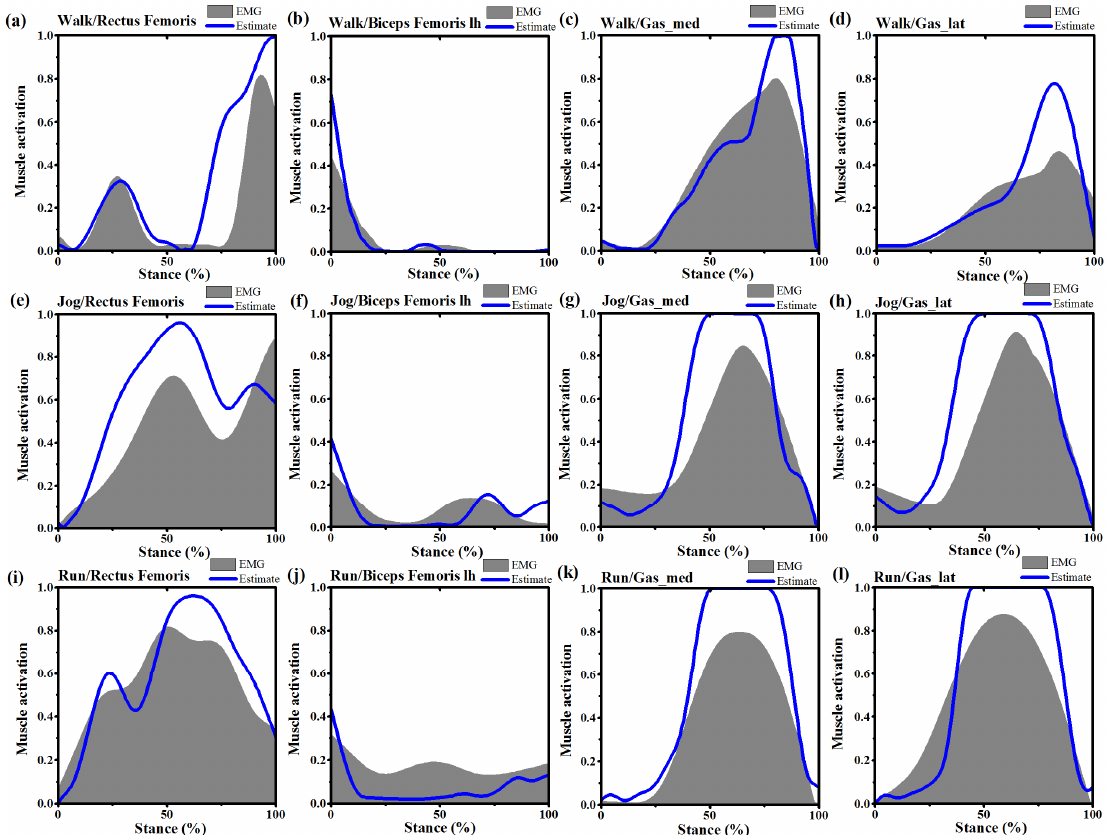
Figure 3. Comparison of muscle activations from static optimization estimated (blue line) and filtered electromyography (EMG) signals measured from one subject during the same trial of normal walking, jogging and running. ( a ): Rectus femoris muscle activation during stance phase of walking; ( b ): Biceps femoris lh (long head) muscle activation during stance phase of walking; ( c ): Gastrocnemius medialis (Gas_med) muscle activation during stance phase of walking; ( d ): Gastrocnemius lateralis (Gas_lat) muscle activation during stance phase of walking; ( e ) Rectus femoris muscle activation during stance phase of jogging; ( f ) Biceps femoris lh (long head) muscle activation during stance phase of jogging; ( g ) Gastrocnemius medialis (Gas_med) muscle activation during stance phase of jogging; ( h ): Gastrocnemius lateralis (Gas_lat) muscle activation during stance phase of jogging; ( i ): Rectus femoris muscle activation during stance phase of running; ( j ): Biceps femoris lh (long head) muscle activation during stance phase of running; ( k ): Gastrocnemius medialis (Gas_med) muscle activation during stance phase of running; ( l ): Gastrocnemius lateralis (Gas_lat) muscle activation during stance phase of running. Note. EMG and activations were normalized from zero to one for each subject based upon the minimum and maximum values over the stance phase.